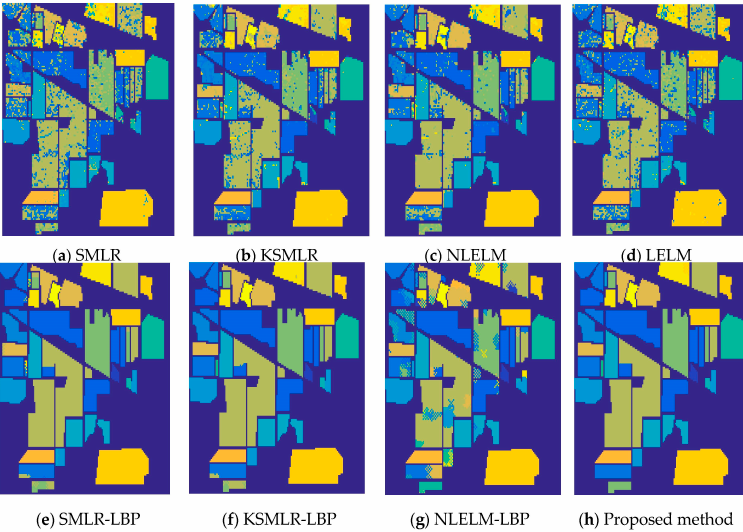
Figure 6. The overall accuracy of Indian Pines image: ( a ) SMLR (OA = 75.76%); ( b ) KSMLR (OA = 84.34%); ( c ) NLELM (OA = 86.93%); ( d ) LELM (OA = 79.43%); ( e ) SMLR-LBP (OA = 98.26%); ( f ) KSMLR-LBP (OA = 99.05%); ( g ) NLELM-LBP (OA = 87.95%); ( h ) Proposed method (OA = 99.75%). Table 2. Indian Pines: overall, average, and individual class accuracy (in percent) and k statistic of different classification methods with 10% training samples. The best accuracy in each row is shown in bold.